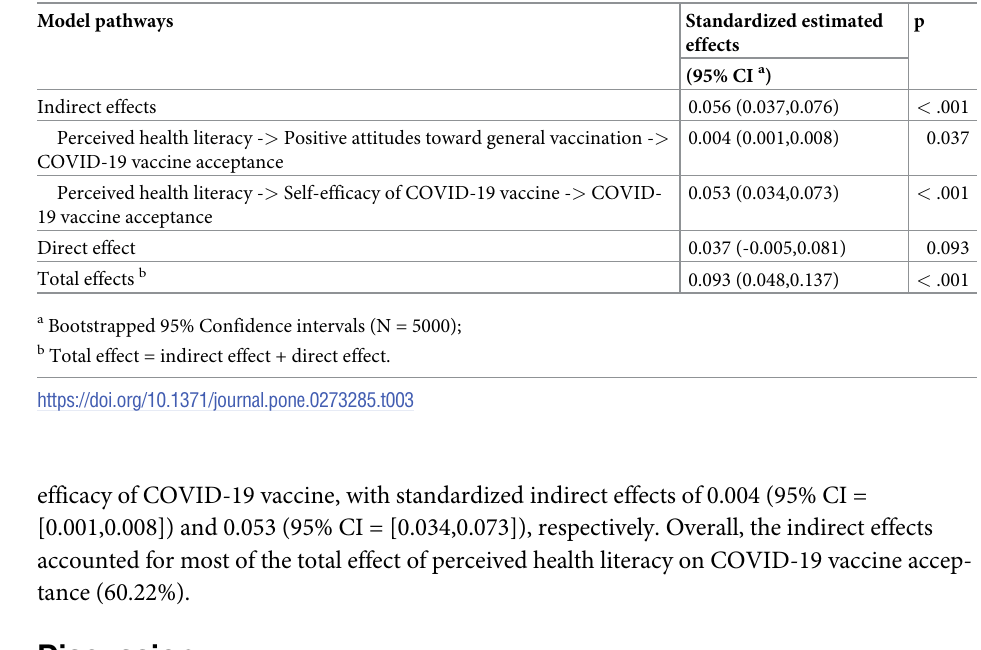
Table 3. Standardized direct, indirect, and total effects for the mediation